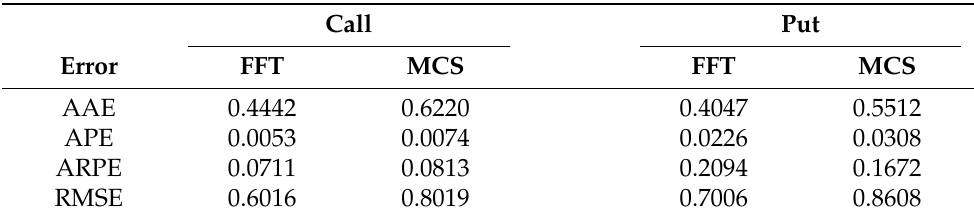
Table 3. Error estimators for the parameter calibration to the call and put option market price on 11